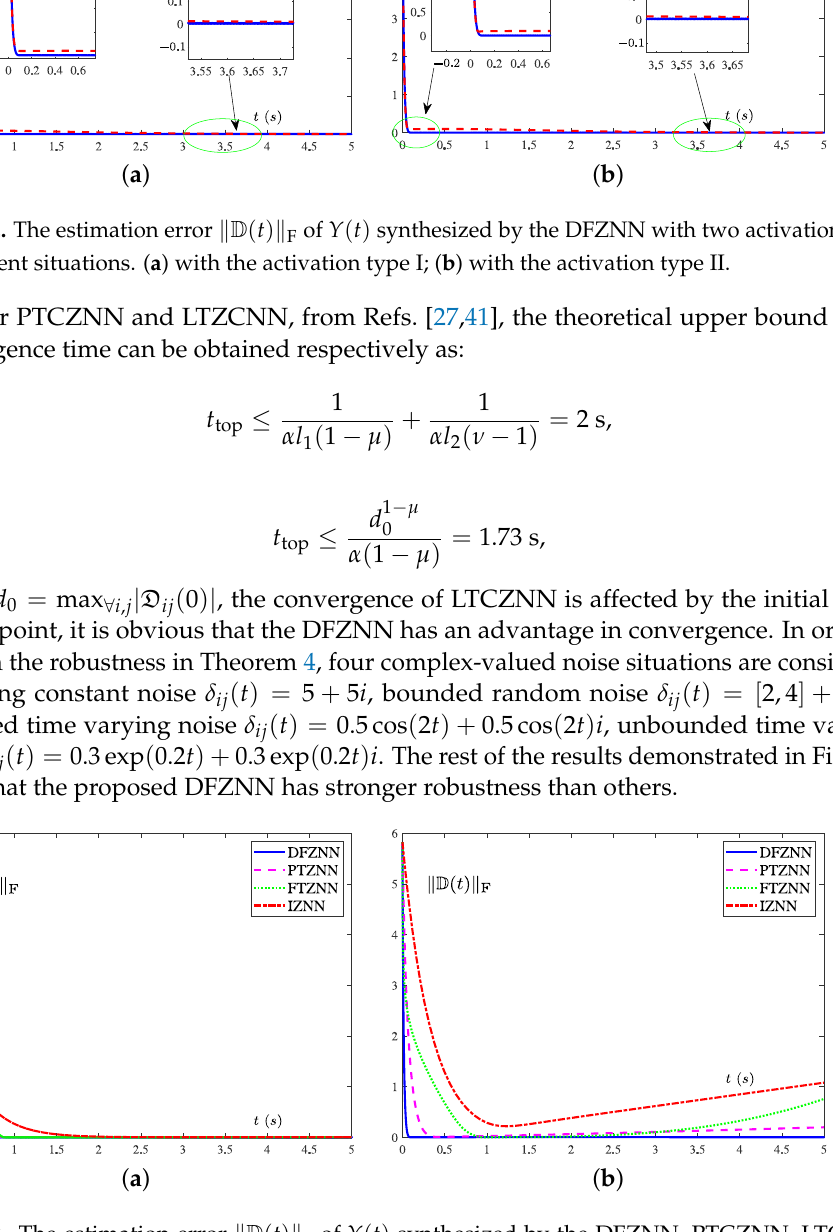
Figure 3. The estimation error (cid:107) D ( t ) (cid:107) F of Y ( t ) synthesized by the DFZNN, PTCZNN, LTCZNN, IZNN with the activation type II. ( a ) zero noise; ( b ) linear time varying noise δ ij ( t ) = 0.5 t + 0.5 t ∗ i